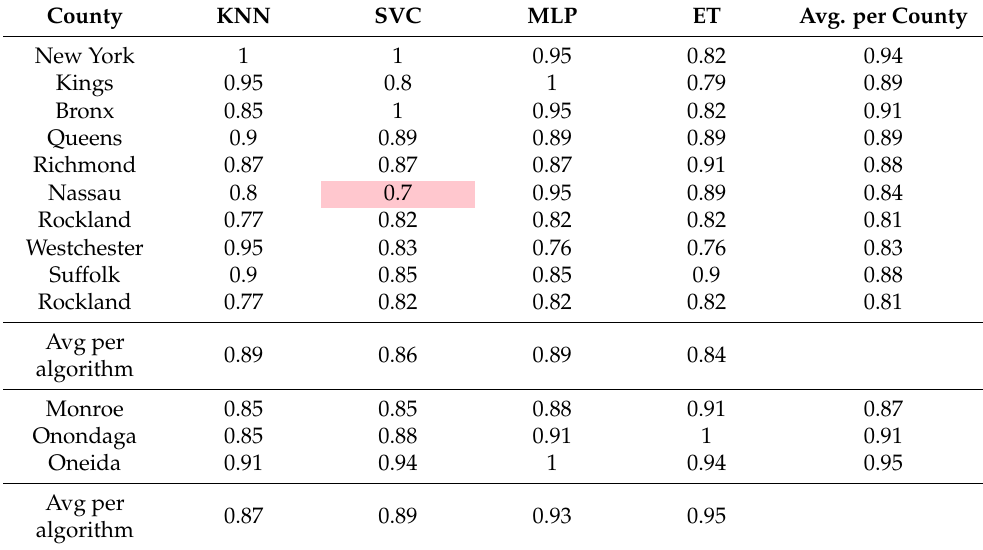
Table 6. ML results: F1-score obtained with data from each county as a validation